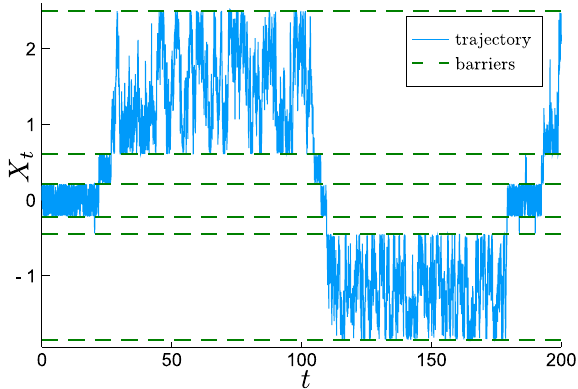
0.01 . Barriers were =